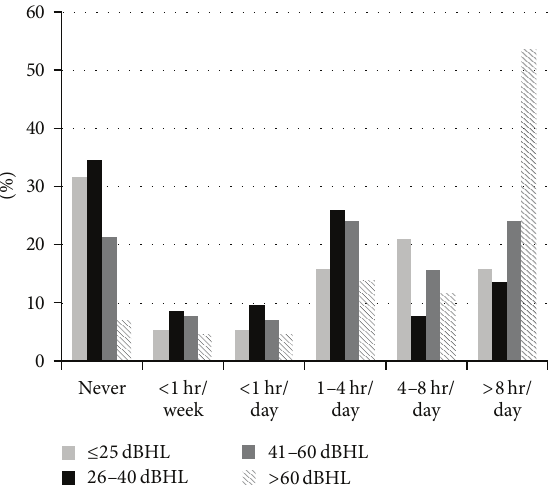
Figure 2: Percentage of time spent wearing hearing aids by magni- tude of hearing loss in the better ear. Amended from Hartley et al.